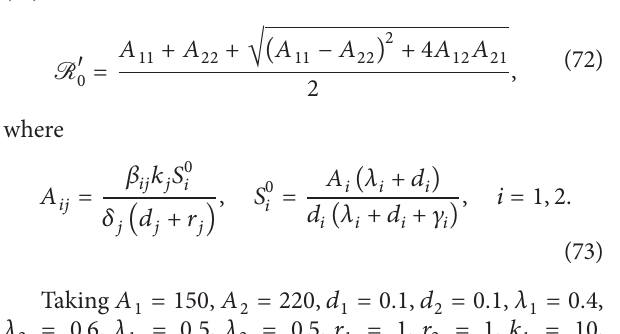
(0) = 260 , 𝐼 (0) = 20 , 2 2